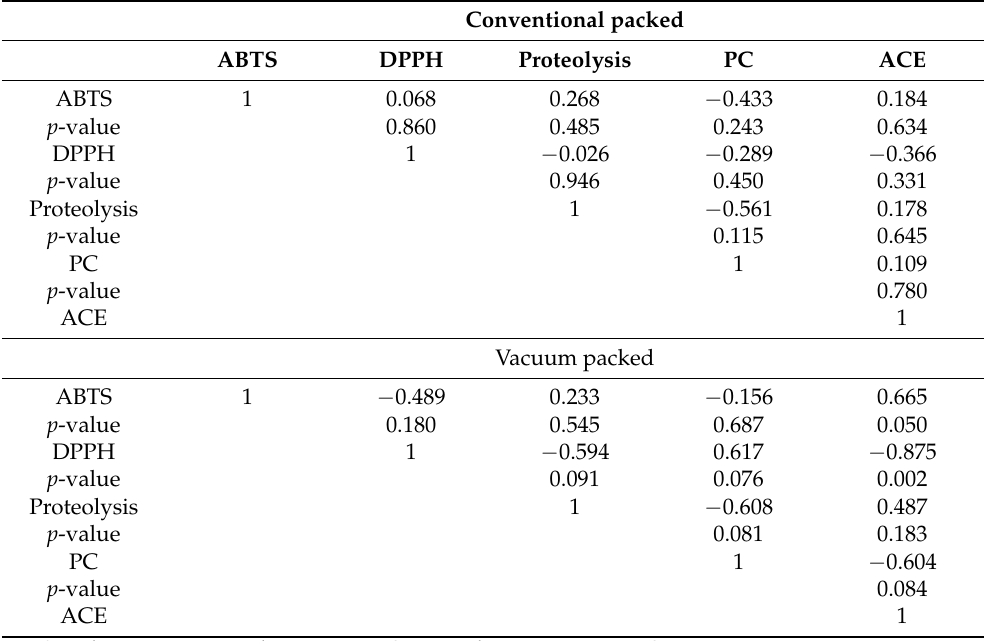
Table 4. Correlation between response variables of T4 requeson cheese (1.5%